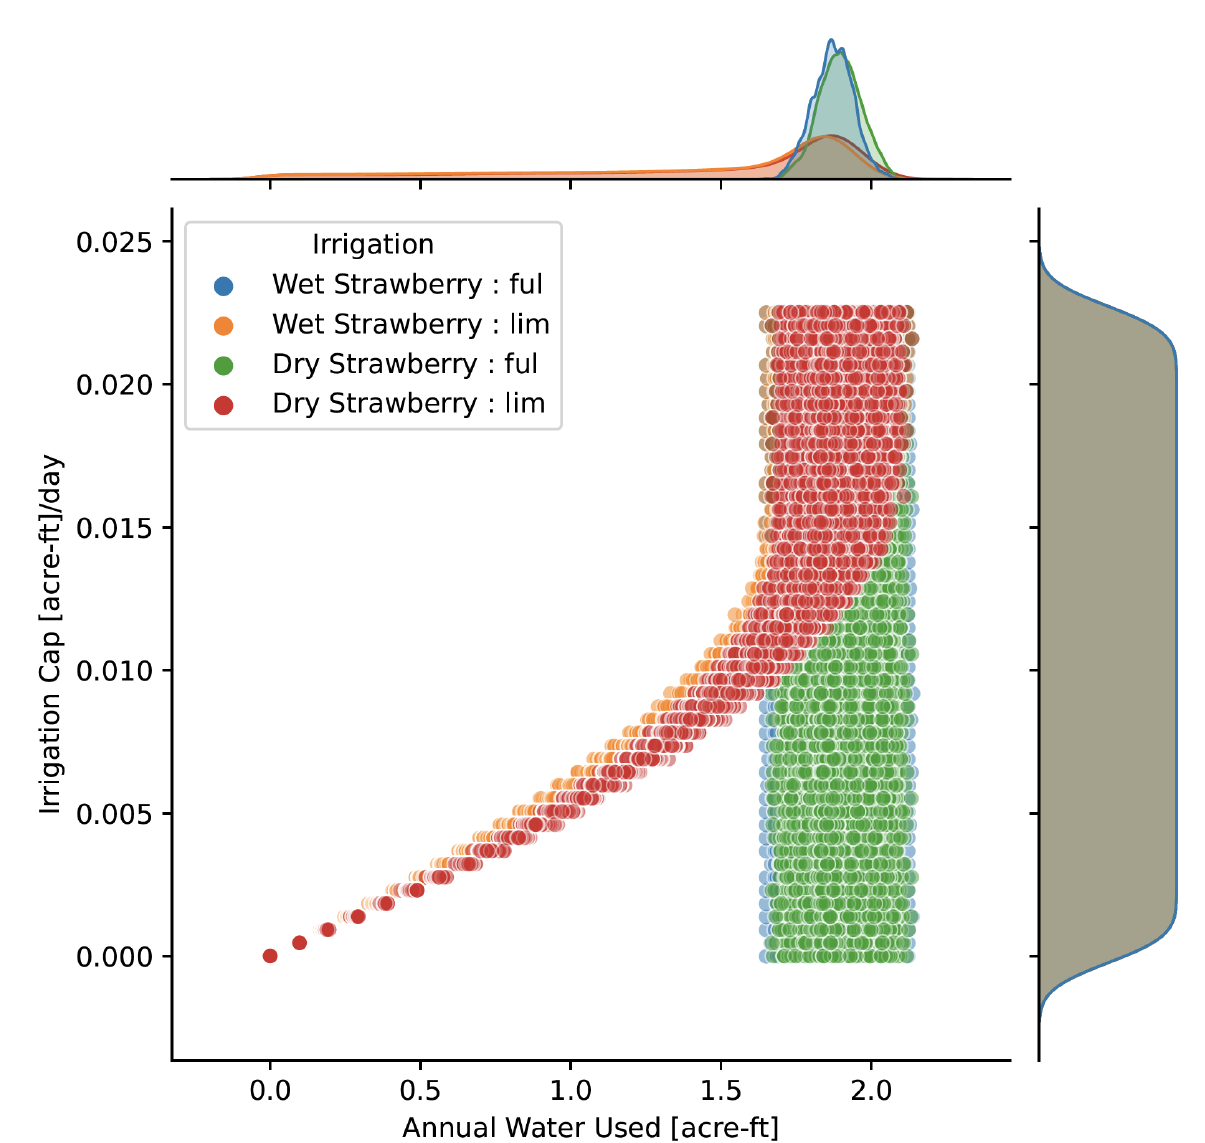
Figure 9. Annual irrigation used for strawberries with water limits drawn from a uniform distribution (on the right ) along with sampled wet and dry forecast environments (along the top ). Water use was maximized after a threshold water limit was reached.